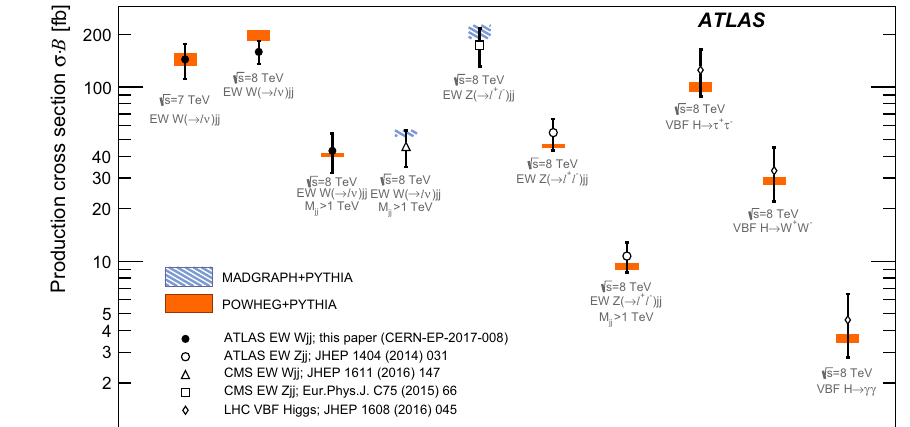
LHC VBF Higgs; JHEP 1608 (2016)